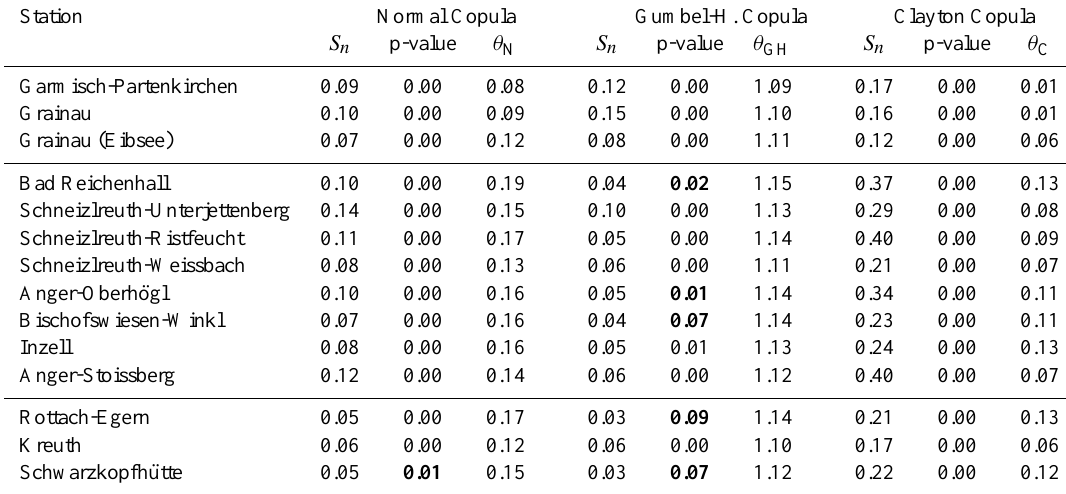
Table 5. Goodness-of-fit (GOF) test using the Cram´er-von-Mises test statistics and parametric bootstrap procedure (see Sect. 3.2.2). p-values exceeding 0.01 are highlighted in bold.